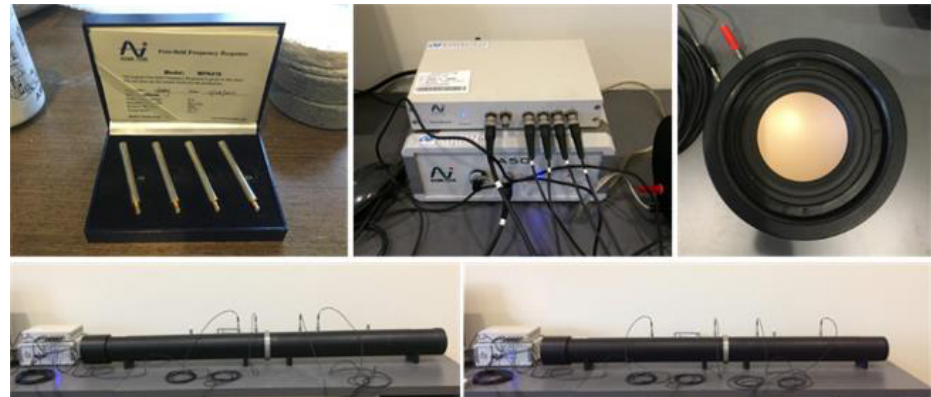
Figure 3. Impedance tube system and 1/4 ″ microphone.